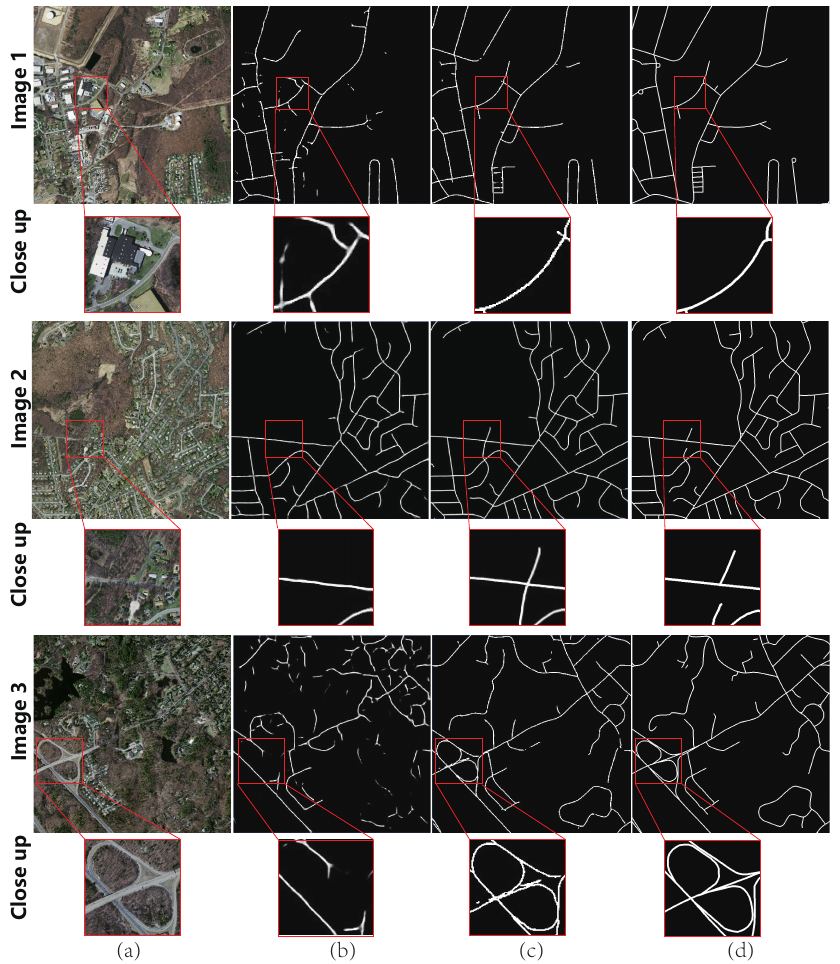
Figure 5. Visualized results of typical examples on Massachusetts dataset: ( a ) original image; ( b ) result of ScGAN; ( c ) result of McGAN; and ( d ) ground